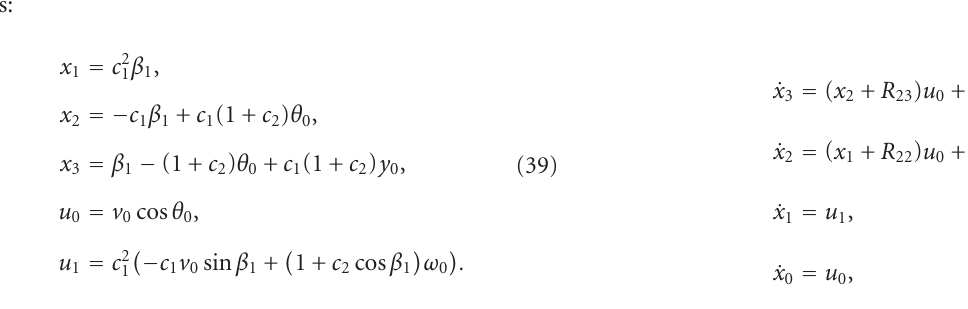
Under the following coordinate and input